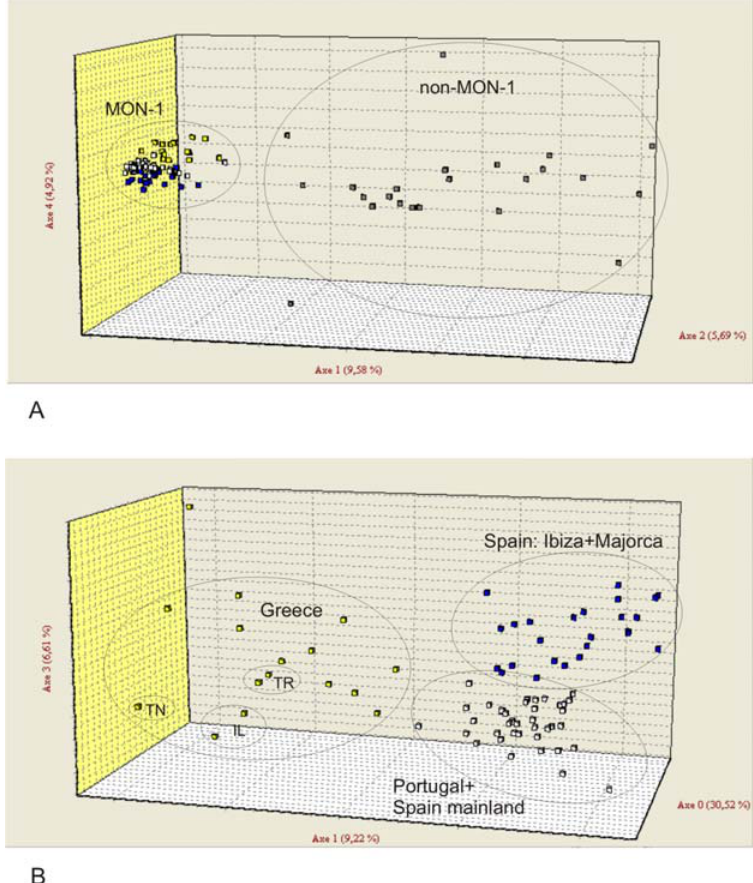
Figure 4. Factorial correspondence analysis (FCA) of L.infantum strains from the Mediterranean region. (A) All MON-1 and non-MON-1 strains included (141 strains). (B) Analysis of the three MON-1 populations (113 strains). TR–Turkey, TN–Tunisia, IL–Israel; Population 1 (Greece)–yellow squares, population 2 (Majorca + Ibiza)–blue squares, population 3 (mainland Spain + Portugal)–white squares, population 4 (non-MON-1)–grey